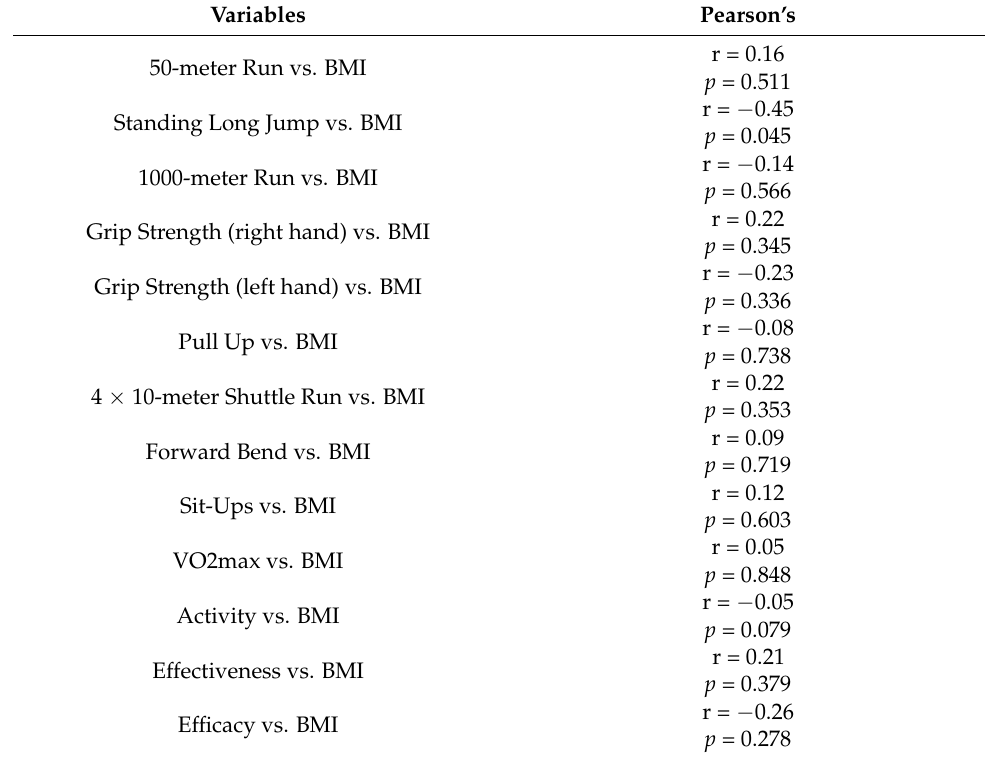
Table 4. Relation between the change of fitness parameters and the change of BMI. Variables